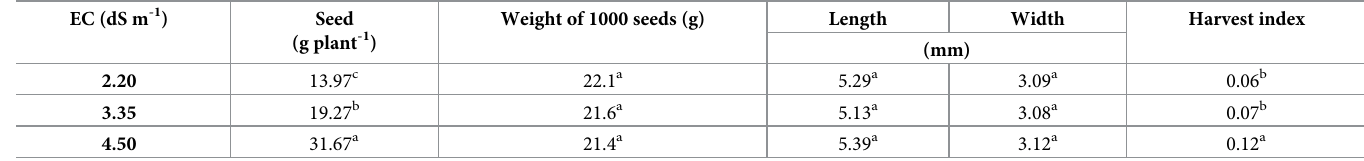
Different letters indicate significant difference at p � 0.05 according to Tukey´s test.